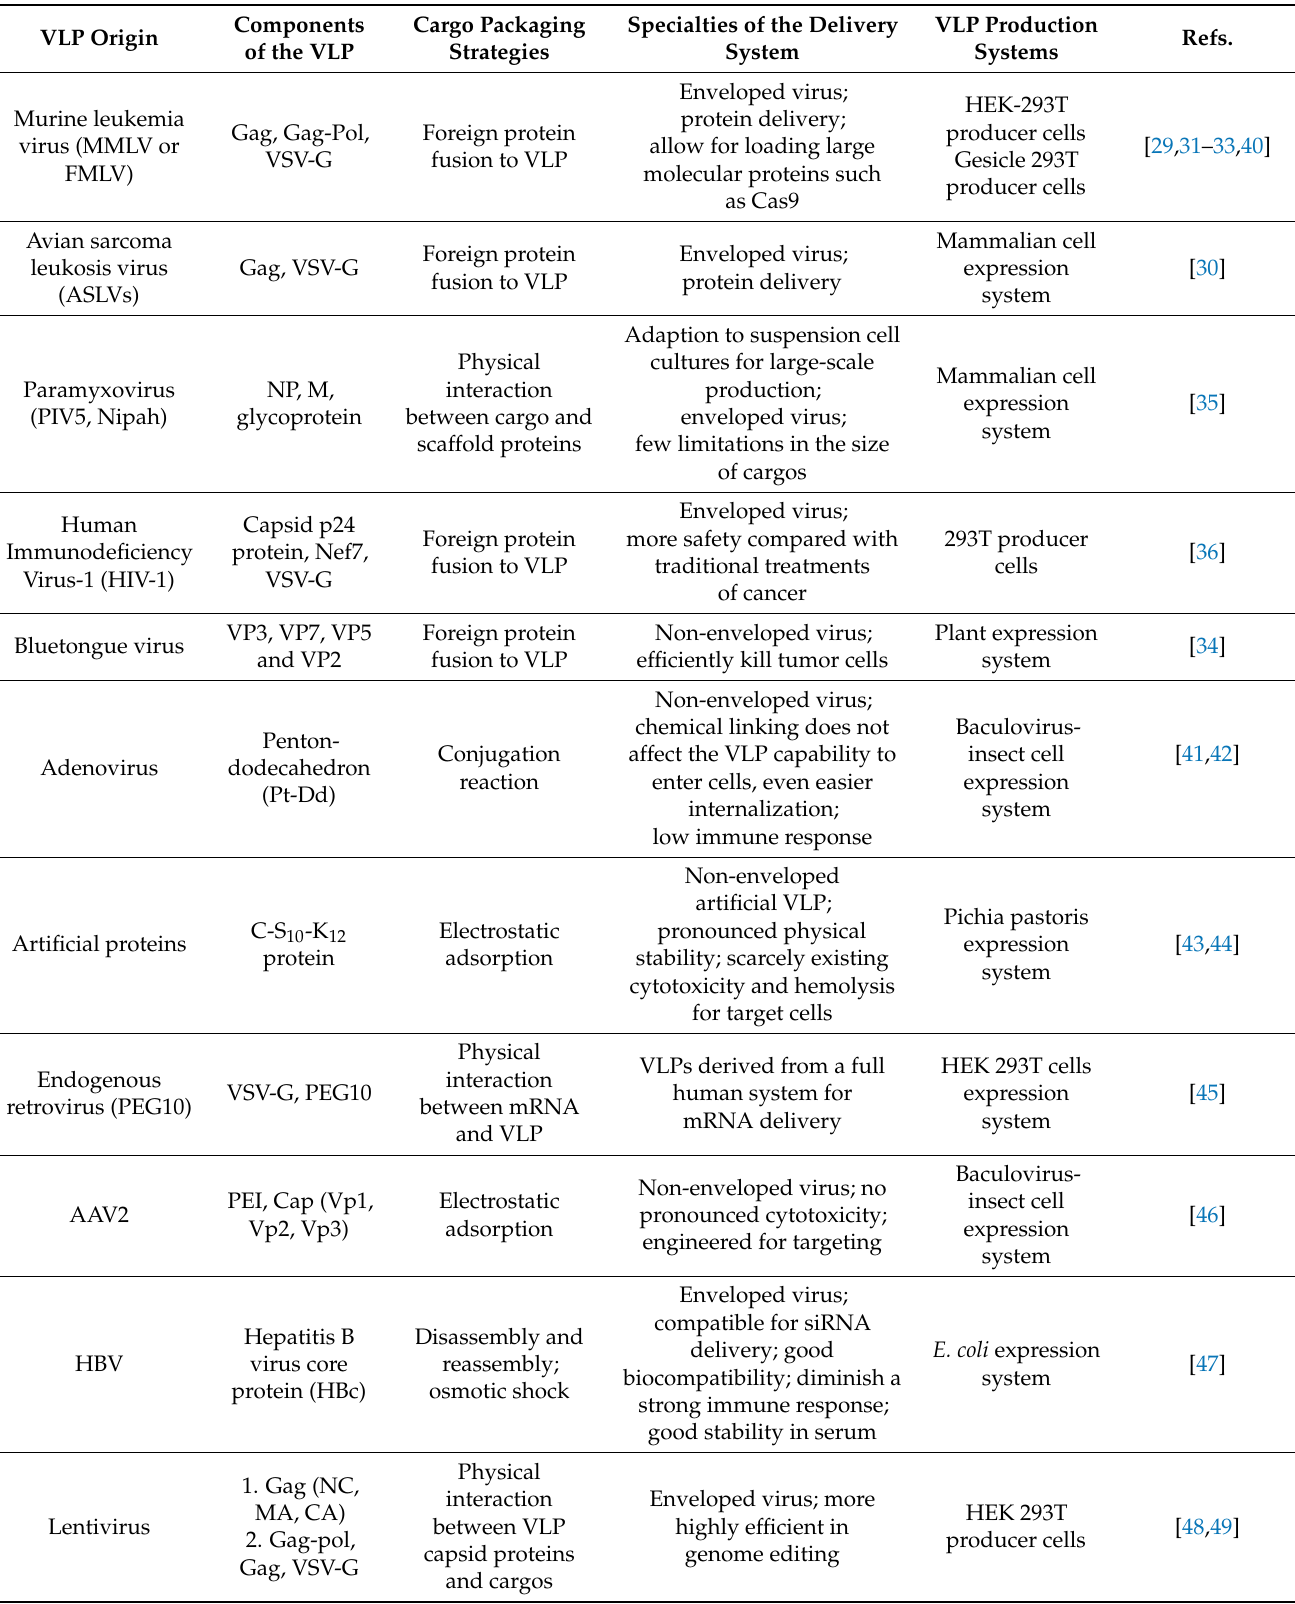
Table 1. VLPs for intracellular delivery of biomolecules and